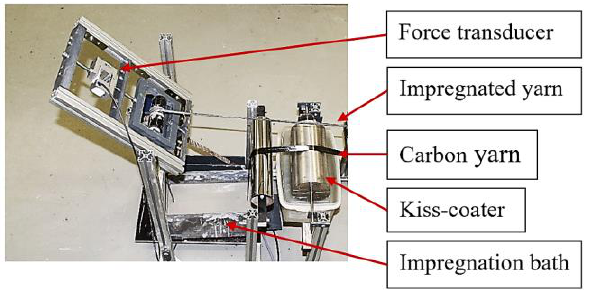
Figure 3. Assembly of force transducer for measuring the yarn tension force.